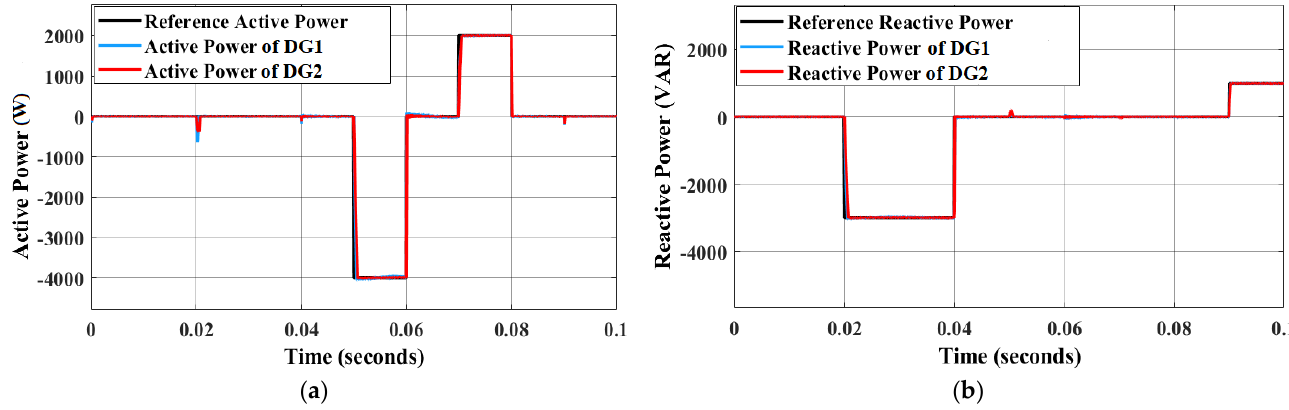
Figure 11. Individual DG power flow control using the proposed PQ control: ( a ) active power and ( b ) reactive power.